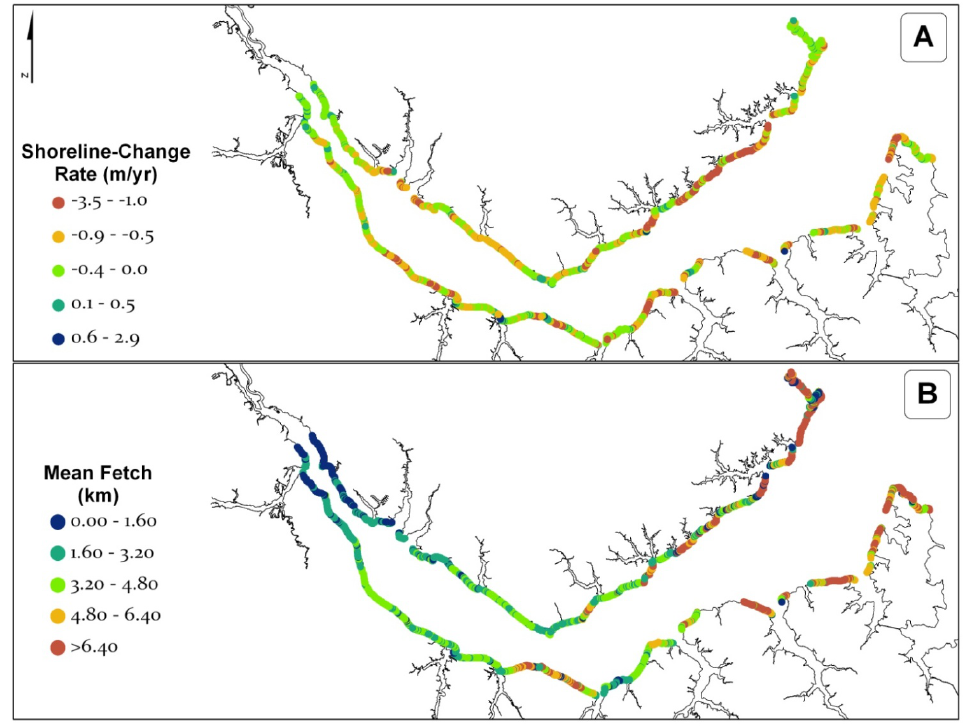
Figure 2. (A) Map of shoreline-change rate distribution along the Neuse River Estuary study area. Areas with higher erosion rates are denoted in warmer colors (yellow to red), and areas that have accreted are represented in cooler colors (blues). (B) Map of mean fetch distribution along the Neuse River Estuary shoreline. High mean fetch values are represented in red and low mean fetch values are denoted as blue.